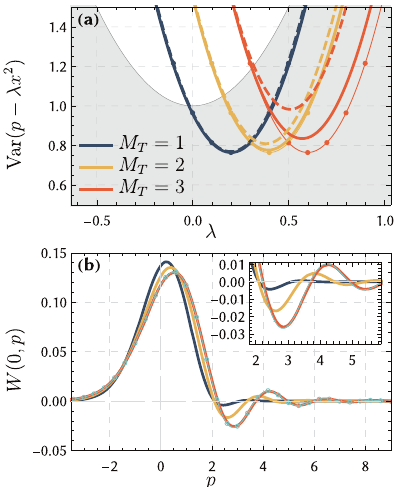
Fig. 2 Results of the simulations. Results of stroboscopic applica- tion of cubic nonlinear potential V = γ x 3 /(6 τ ) to the squeezed thermal state (initial occupation n 0 = 0.05, squeezing s = 1.2) over multiple ( M T = 1, 2, or 3) halves of mechanical periods. a Squeezing of nonlinear quadrature. Thick lines correspond to stroboscopic method with realistic parameters and thermal noise, thin lines, to purely unitary application of the nonlinearity. Dashed lines correspond to the result of evolution driven by the full Hamiltonian ^ H (1) from the same initial state over time τ , 2 τ , and 3 τ respectively. b Wigner function of motional states. Solid lines correspond to the same states from ( a ). Cyan line with markers (overlapping with solid red line) shows the unitary application of nonlinearity. Other parameters are as follows: potential stiffness γ = γ 0 = 0.2, application duration τ Ω m = Θ = Θ 0 = π /100, environmental thermal heating rate parameter H 0 = 4 π H m / Ω m =